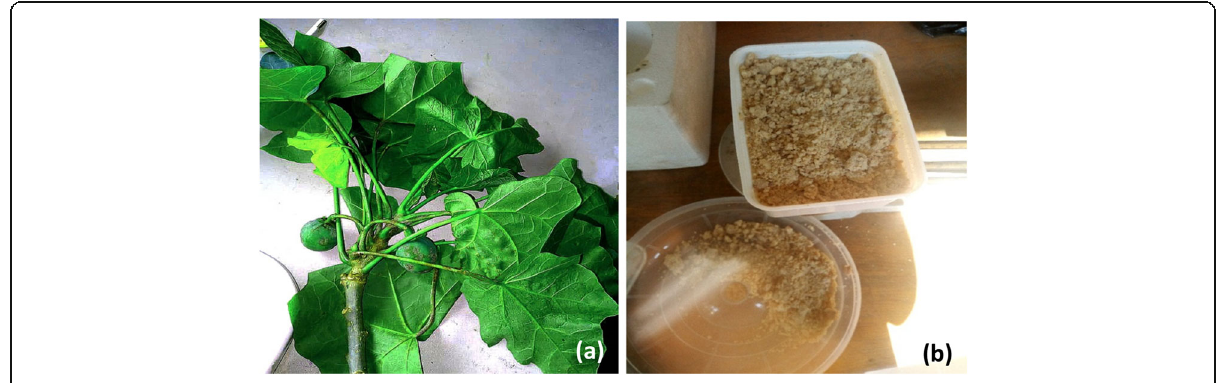
Fig. 1 Jatropha curcas a leaves and seeds. b Pulverized